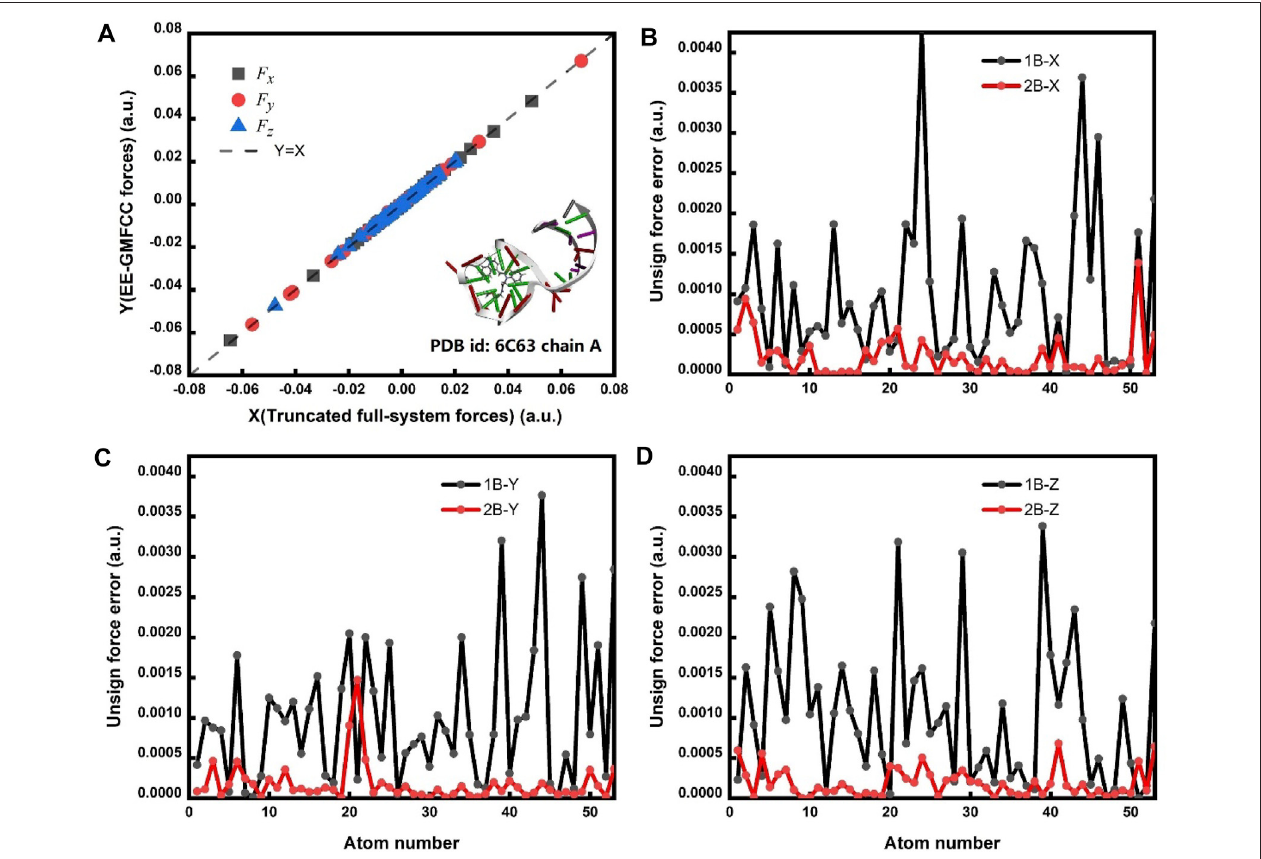
FIGURE5|(A) CorrelationofthecalculatedatomicforcesbetweentheEE-GMFCCmethodandtruncatedfull-systemcalculations. F x , F y ,and F z arethecalculated atomic forces for all atoms of the fl uorophore in x , y , and z directions, respectively. The calculations were performed at the TD-HF/6-31G* level. The dashed line is the strictcorrelation curve. The mean unsigned error (MUE) between theEE-GMFCC and the truncated full-system method is0.00022hartree/bohr. (B) The unsigned error for F x between the EE-GMFCC method and truncated full-system calculationsunder the one-body (1B) and two-body(2B) treatment. (C) Similar topanel b but for F y . (D) Similar to panel b but for F z